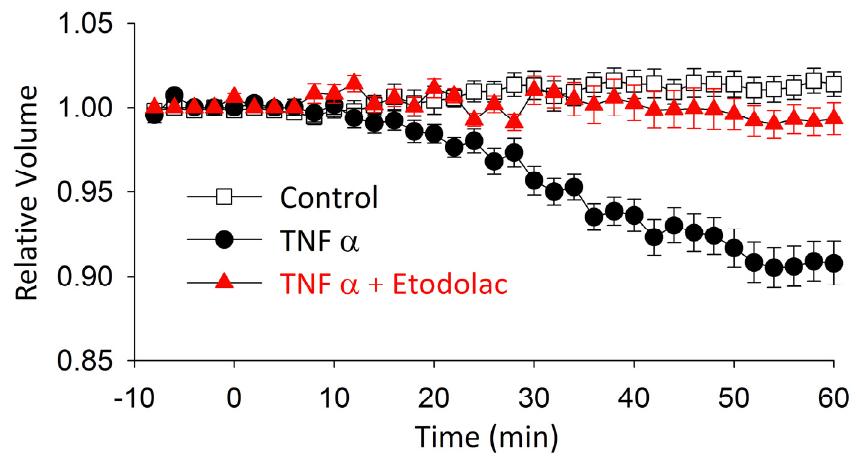
Figure 3. Effect of etodolac on TNF- α -induced decrease in relative cross-sectional area of cells. At time 0, drugs were added to the perfusion